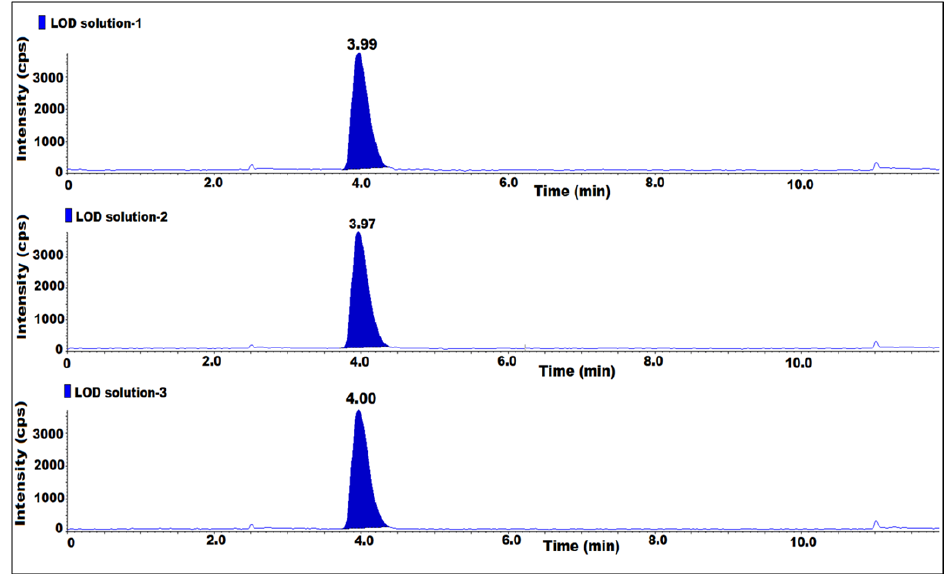
Figure 4. MS/MS MRM chromatogram of LOD solution.